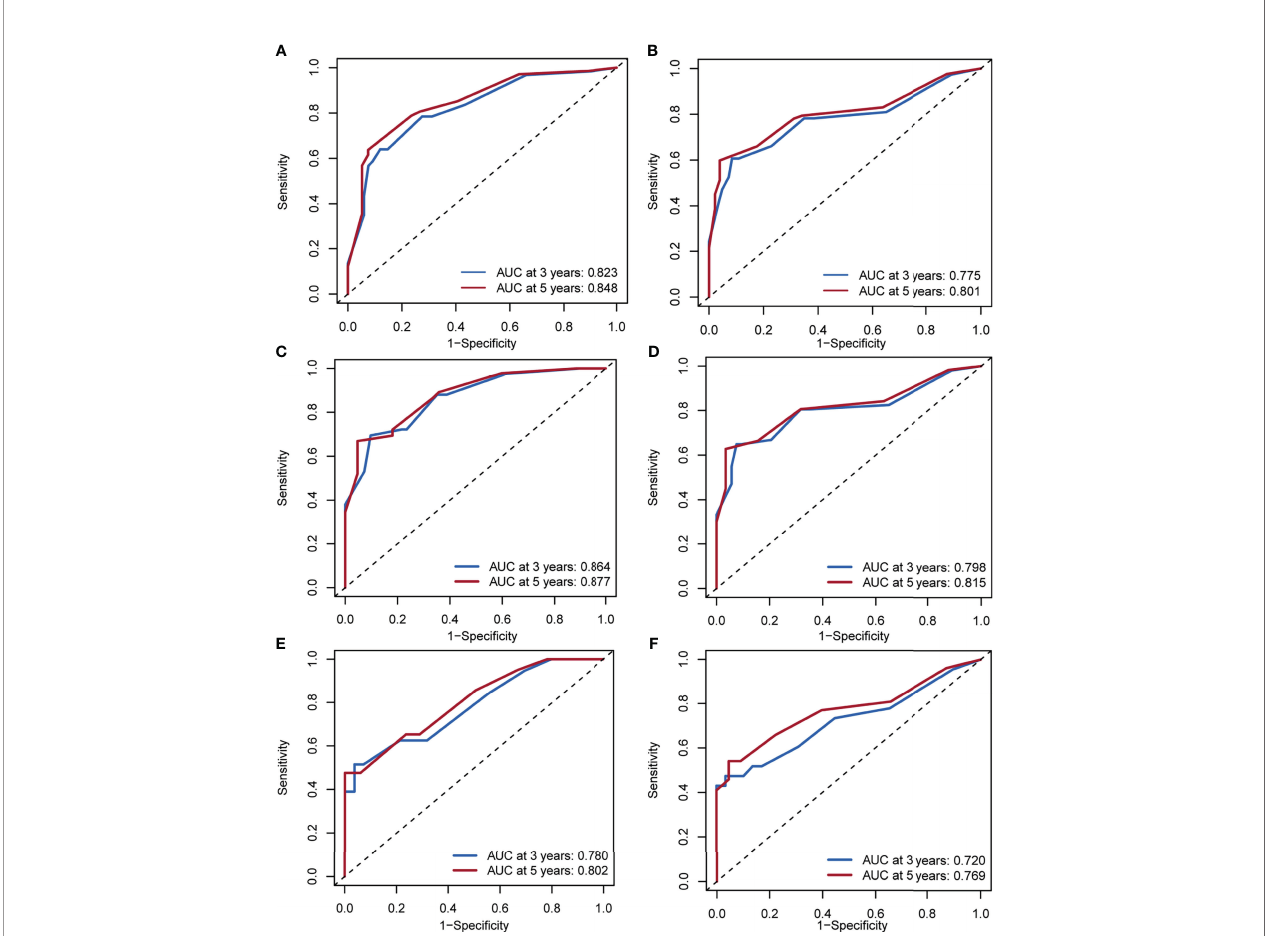
FIGURE 5 | Area under the receiver operating characteristic curve for 3- and 5-year disease-speci fi c survival and overall survival in the whole cohorts (A, B) , training cohorts (C, D) and validation cohorts (E, F)